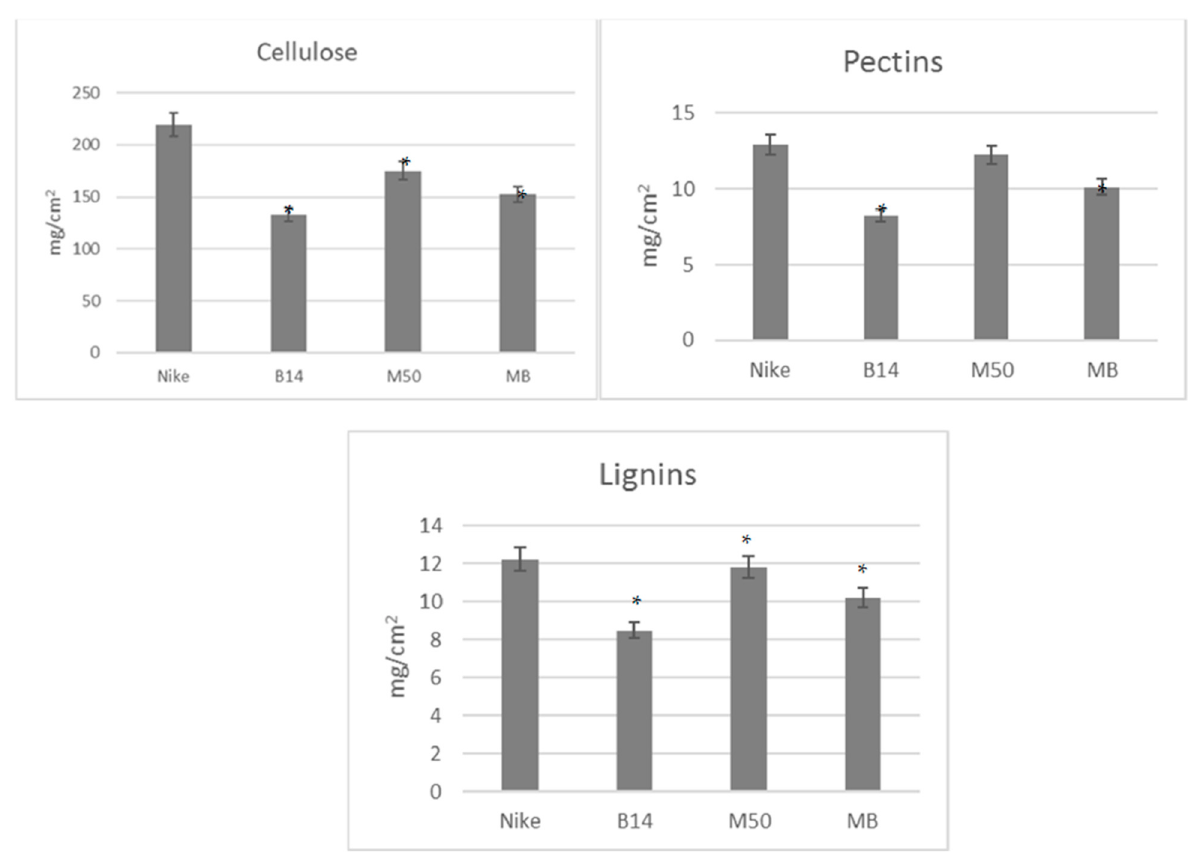
Figure 1. The content of the main polymers in the studied fabrics. The statistical significance of the differences between the results for the tested linen fabrics compared to the control was calculated using the Tukey post hoc test (* p < 0.05).